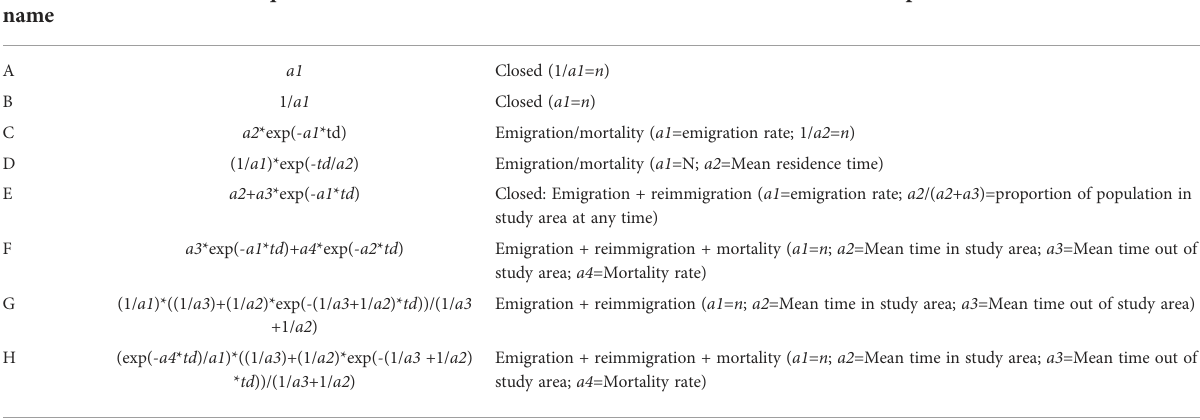
TABLE 2 Models used to assess scenarios of population closure, mortality or permanent emigration, residency and population size in the study area ( n ).